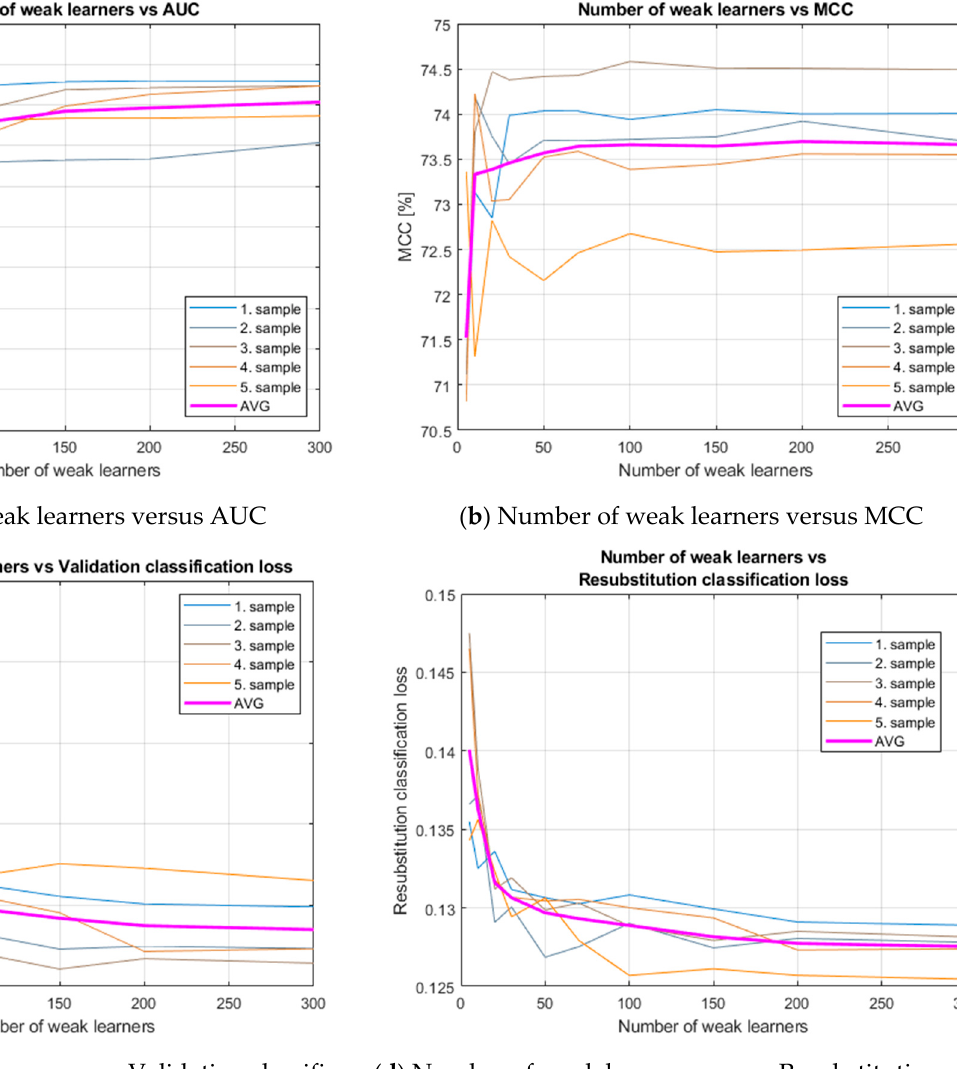
tion losses in the RobustBoost element. losses in the RobustBoost